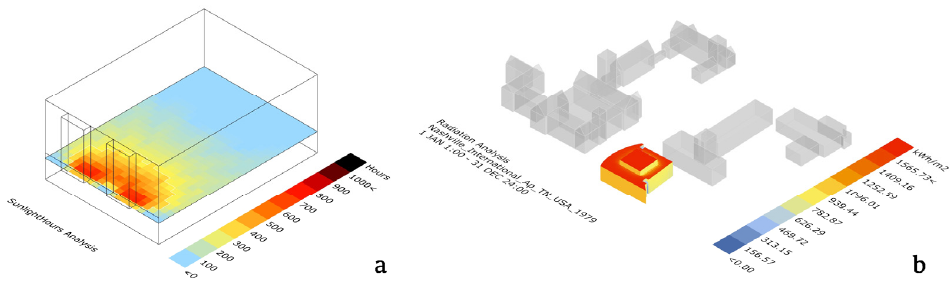
Figure 9. Simulation results of sunshine hours ( a ) and sunshine radiation ( b ) in the official Ladybug Tools sample file.